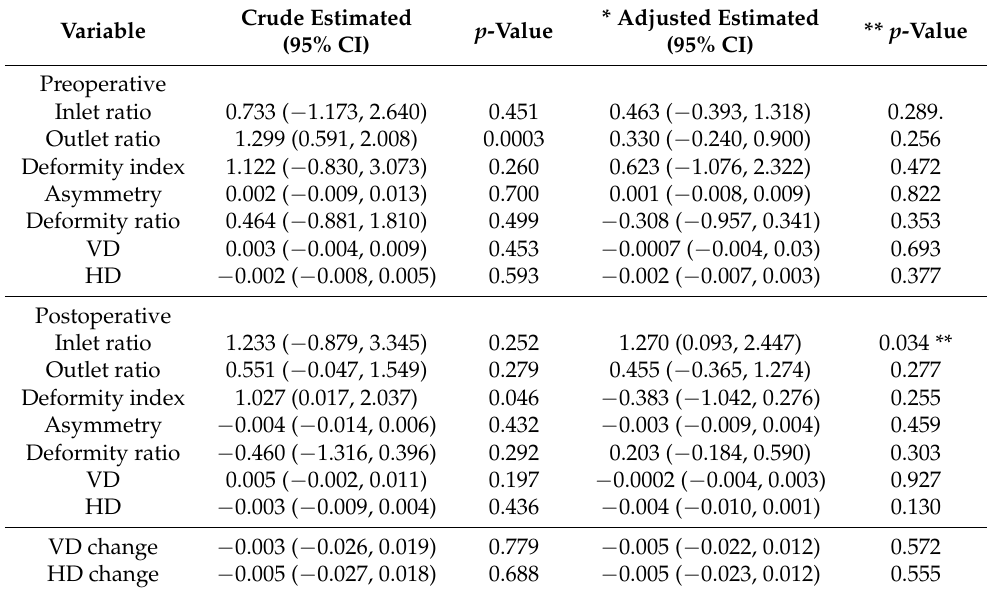
Table 5. Associations between the EQ − VAS score and measurements in the GEE model.